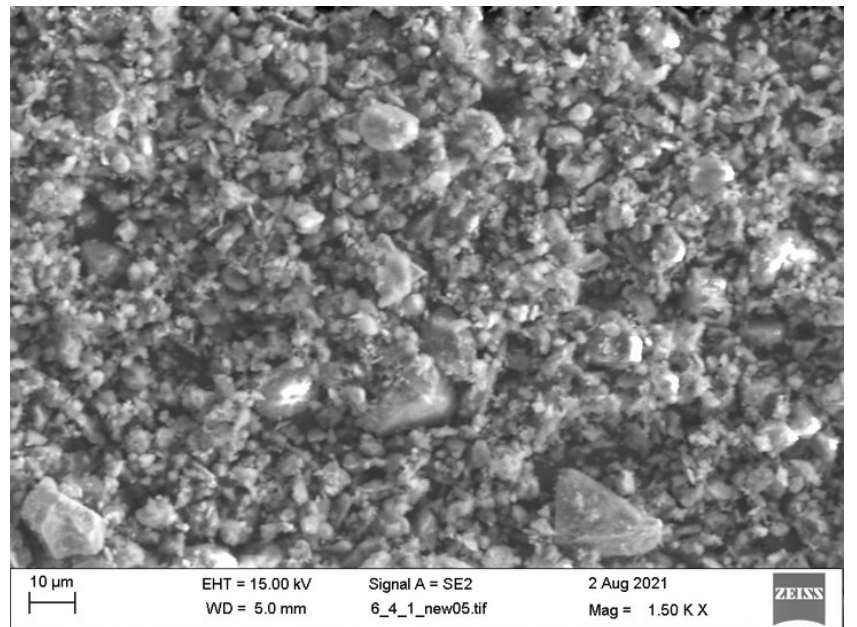
Figure 4. SEM image of clay calcined at 800 °C.